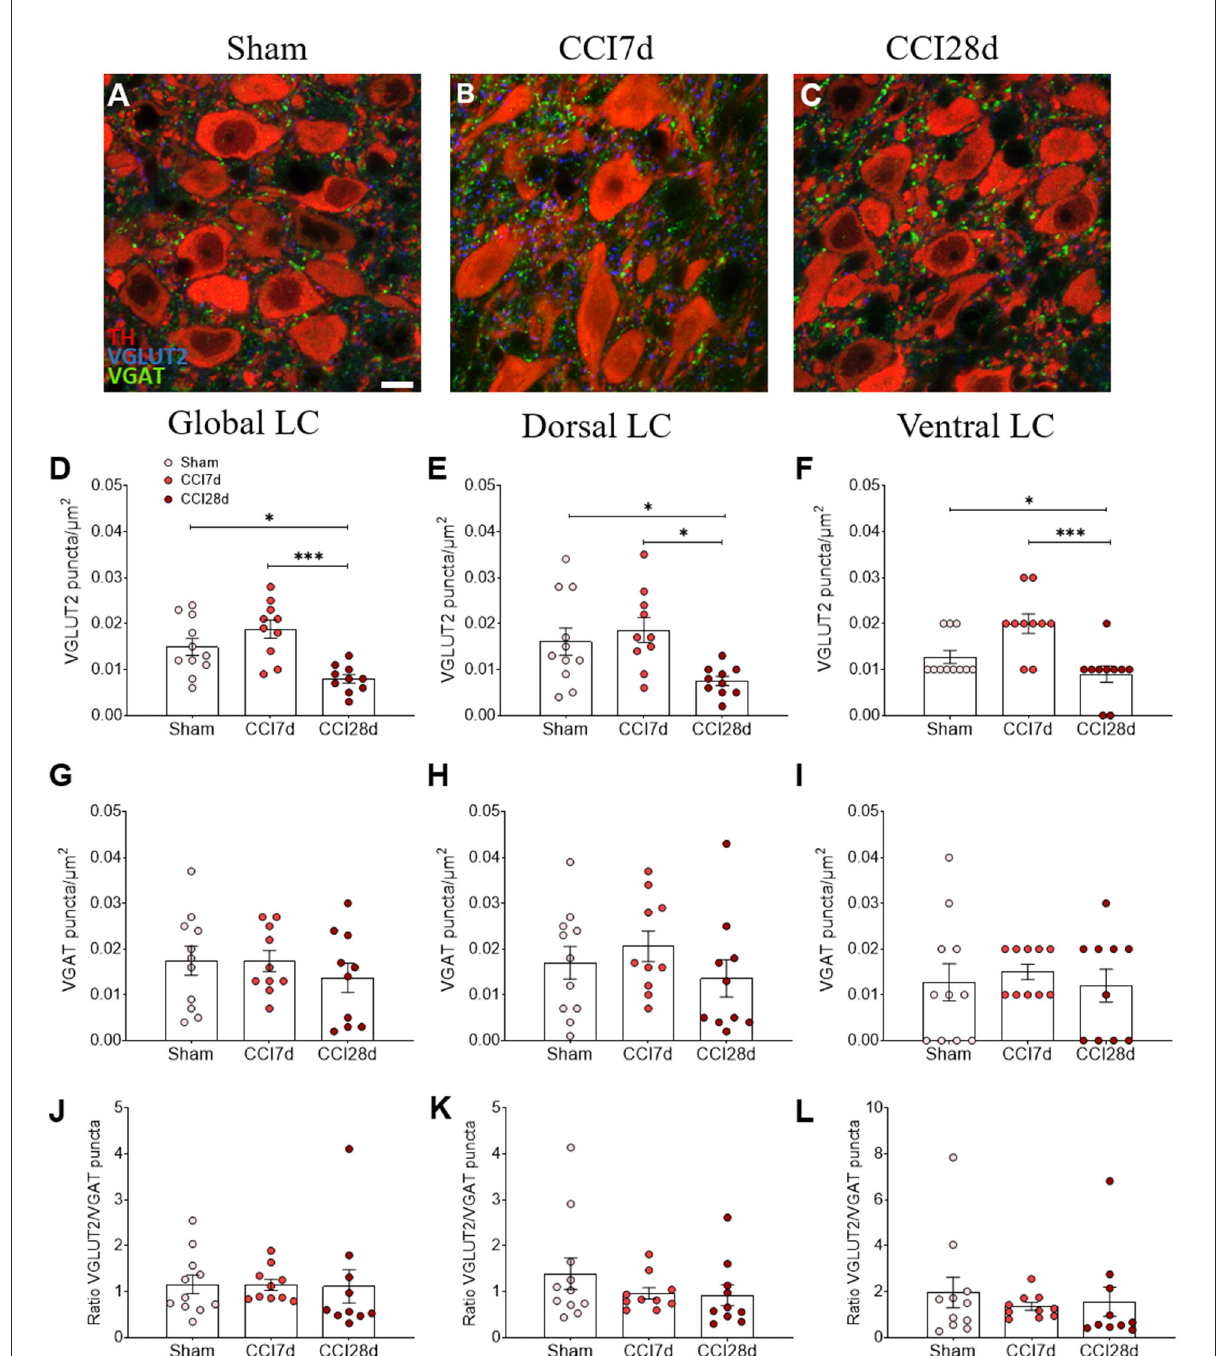
FIGURE3 VGLUT2 and VGAT expression in the LC of neuropathic pain rats. (A–C) Representative confocal images showing the density of puncta expressing VGLUT2 and VGAT in the LC of (A) Sham, (B) CCI7d, and (C) CCI28d rats (TH red; VGLUT2 blue; VGAT green: scale bar, 10 µ m). (D–F) Quantification of the density of puncta expressing VGLUT2 in the (D) global, (E) dorsal, and (F) ventral LC. (G–I) Quantification of the density of VGAT puncta in the (G) global, (H) dorsal, and (I) ventral LC. (J–L) Representation of the ratio of VGLUT2/VGAT puncta in the (J) global, (K) dorsal, and (L) ventral LC. The data represent the mean ± SEM of the number of the puncta/ µ m 2 (obtained from three to four quadrants in a total of three LC sections per rat): * p < 0.05, *** p < 0.001 vs. the corresponding group, one-way ANOVA followed by a Tukey’s